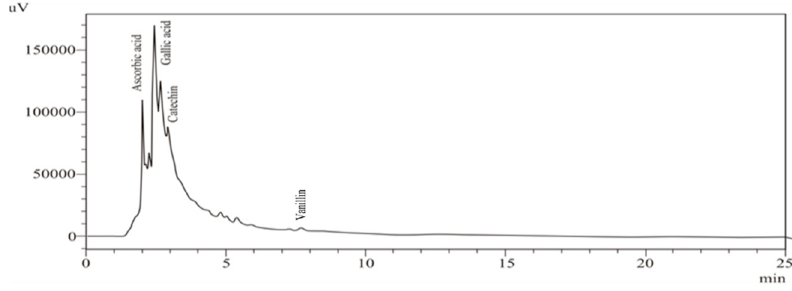
Figure 2. Phenolic acid composition of fermented rice bran (4th day) at 280 nm. Table 3. Phenolic acid composition of un-fermented and fermented rice bran (4th day). Compounds